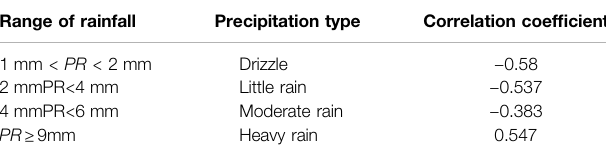
TABLE 2 | Correlation coef fi cient between precipitation intensity and the four categories of precipitation events on the interannual